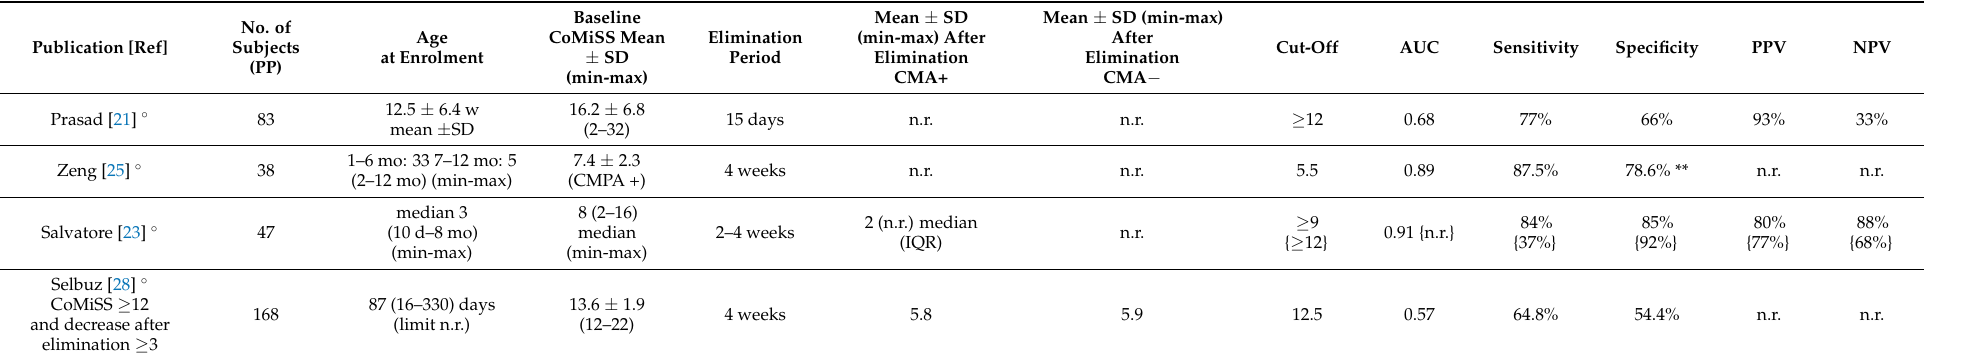
Table 6. Validation studies on CoMiSS in CMA suspected and CM allergic